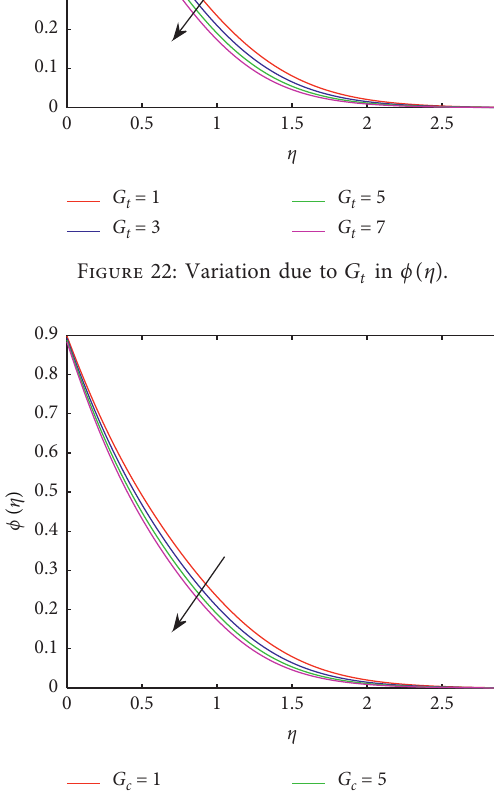
Figure 23: Variation due to G